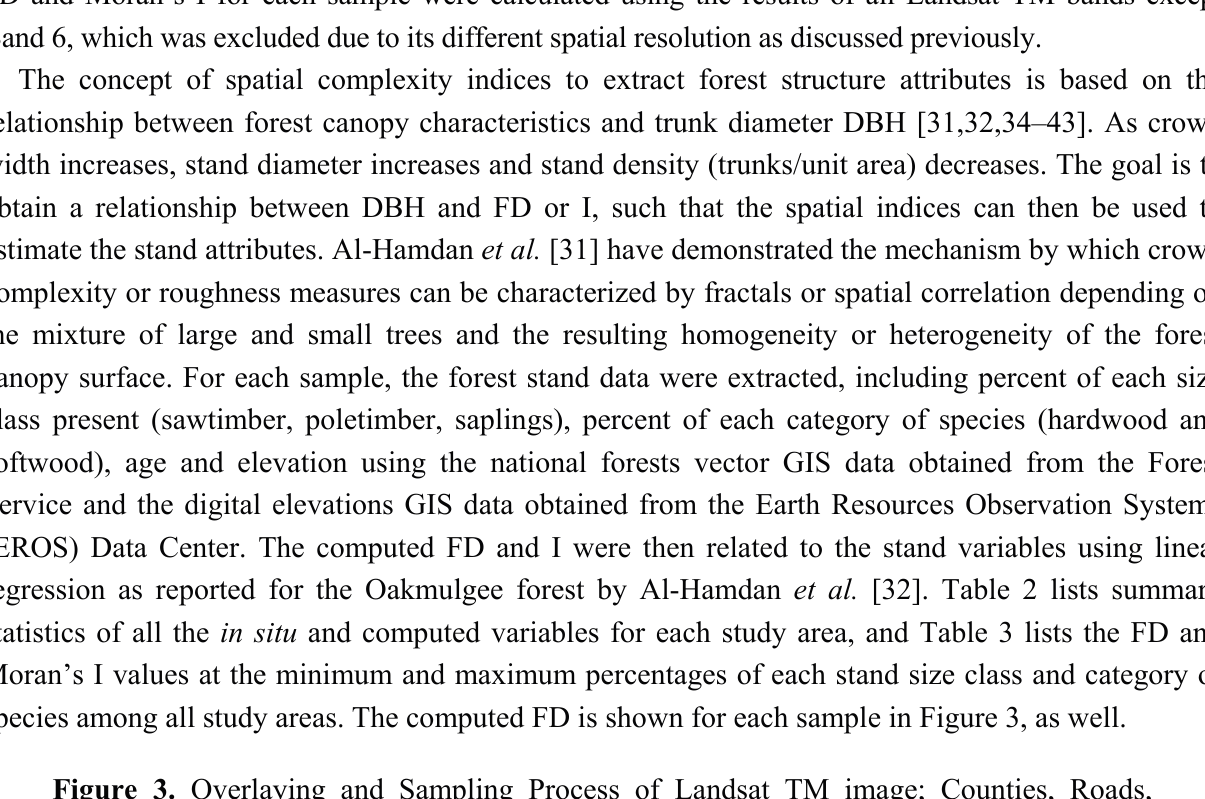
Figure 3. Overlaying and Sampling Process of Landsat TM image; Counties, Roads, and City Locations; DLGs; and FD values at Samples Locations for ( a ) Talladega, ( b ) Oakmulgee, ( c ) Bankhead, and ( d ) Chatahoochee national